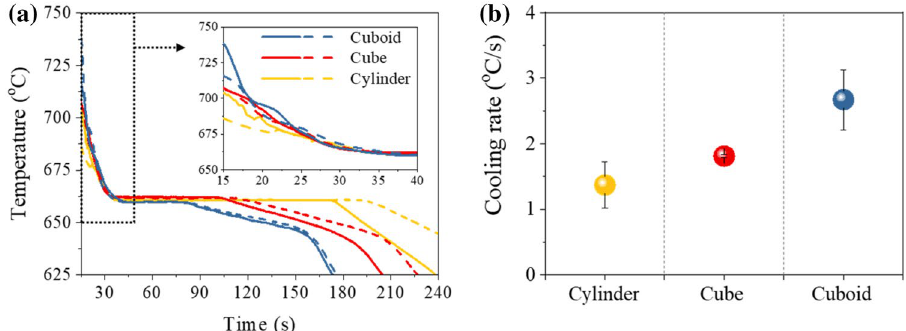
Figure 2. ( a ) Cooling curve measured at the mid-height of the mold, and ( b ) cooling rate of the cylinder-, cube-, and cuboid-shaped cavities without applying electric current during solidification (Non-EA solidification). The solid and dashed line in ( a ) are the results of repeated experiments to confirm the reproducibility.